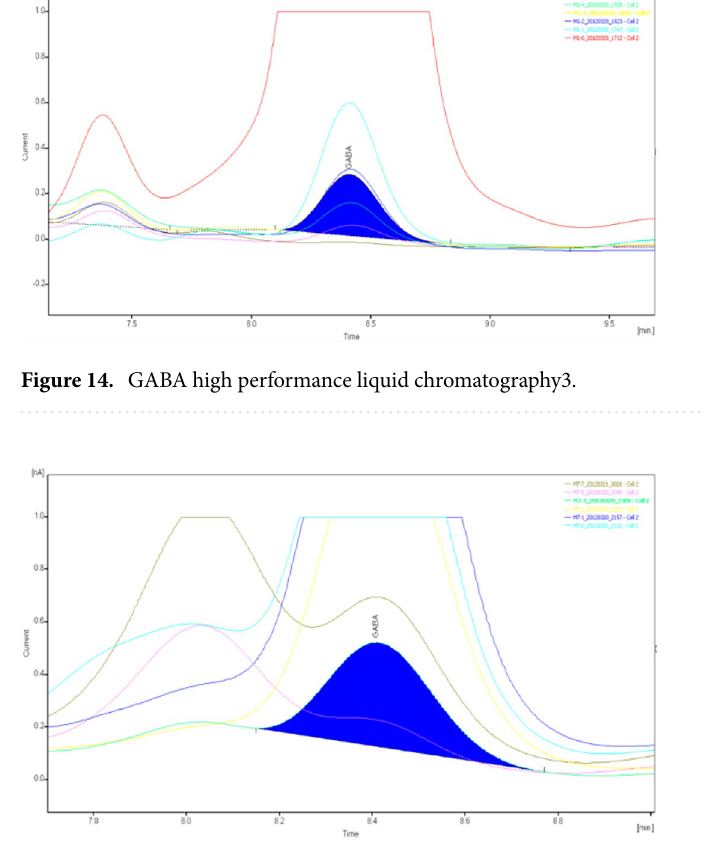
Figure 15. GABA high performance liquid chromatography4.